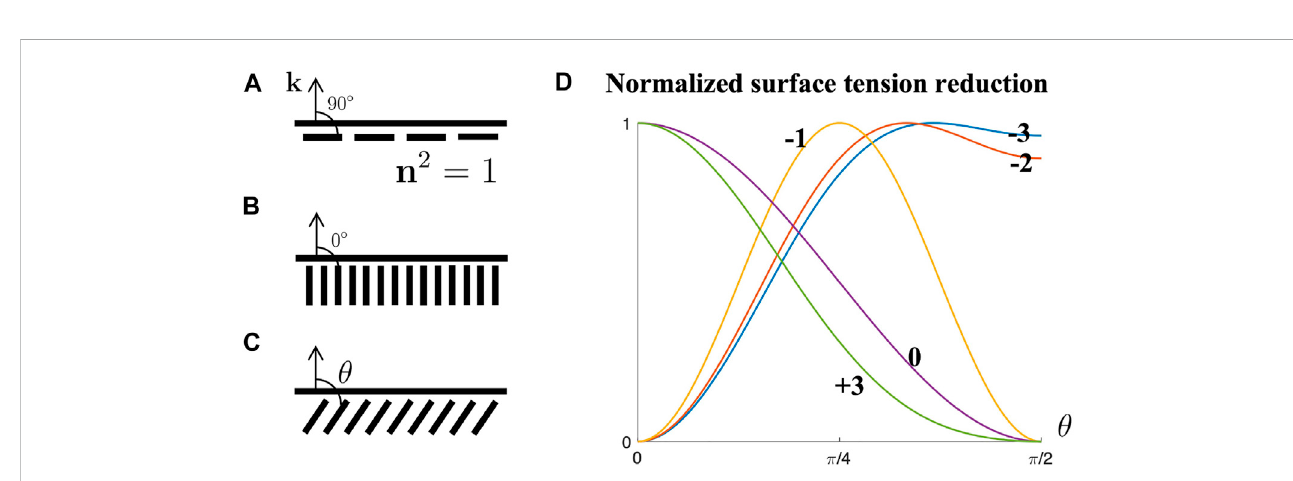
FIGURE 3 (A) Planar anchoring. (B) Homeotropic anchoring. (C) Oblique anchoring. (D) Normalized surface tension reduction Norm [( γ − γ 0 )/ μ 2 ] as a function of oblique angle θ with varying μ 4 / μ 2